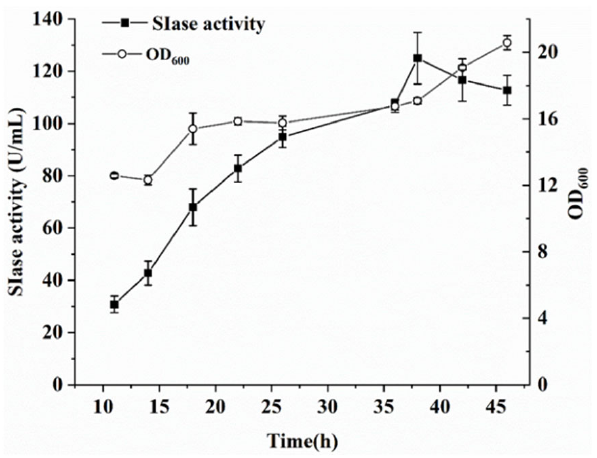
Figure 2. Fed ‐ batch fermentation of the recombinant WB800N/pHT254 ‐ Pgrac100 ‐ WapA ‐ SIase in a 5 ‐ L fermenter. Extracellular SIase activity (filled square), biomass (open cycle). Data are the means ± SD from triplicate samples.